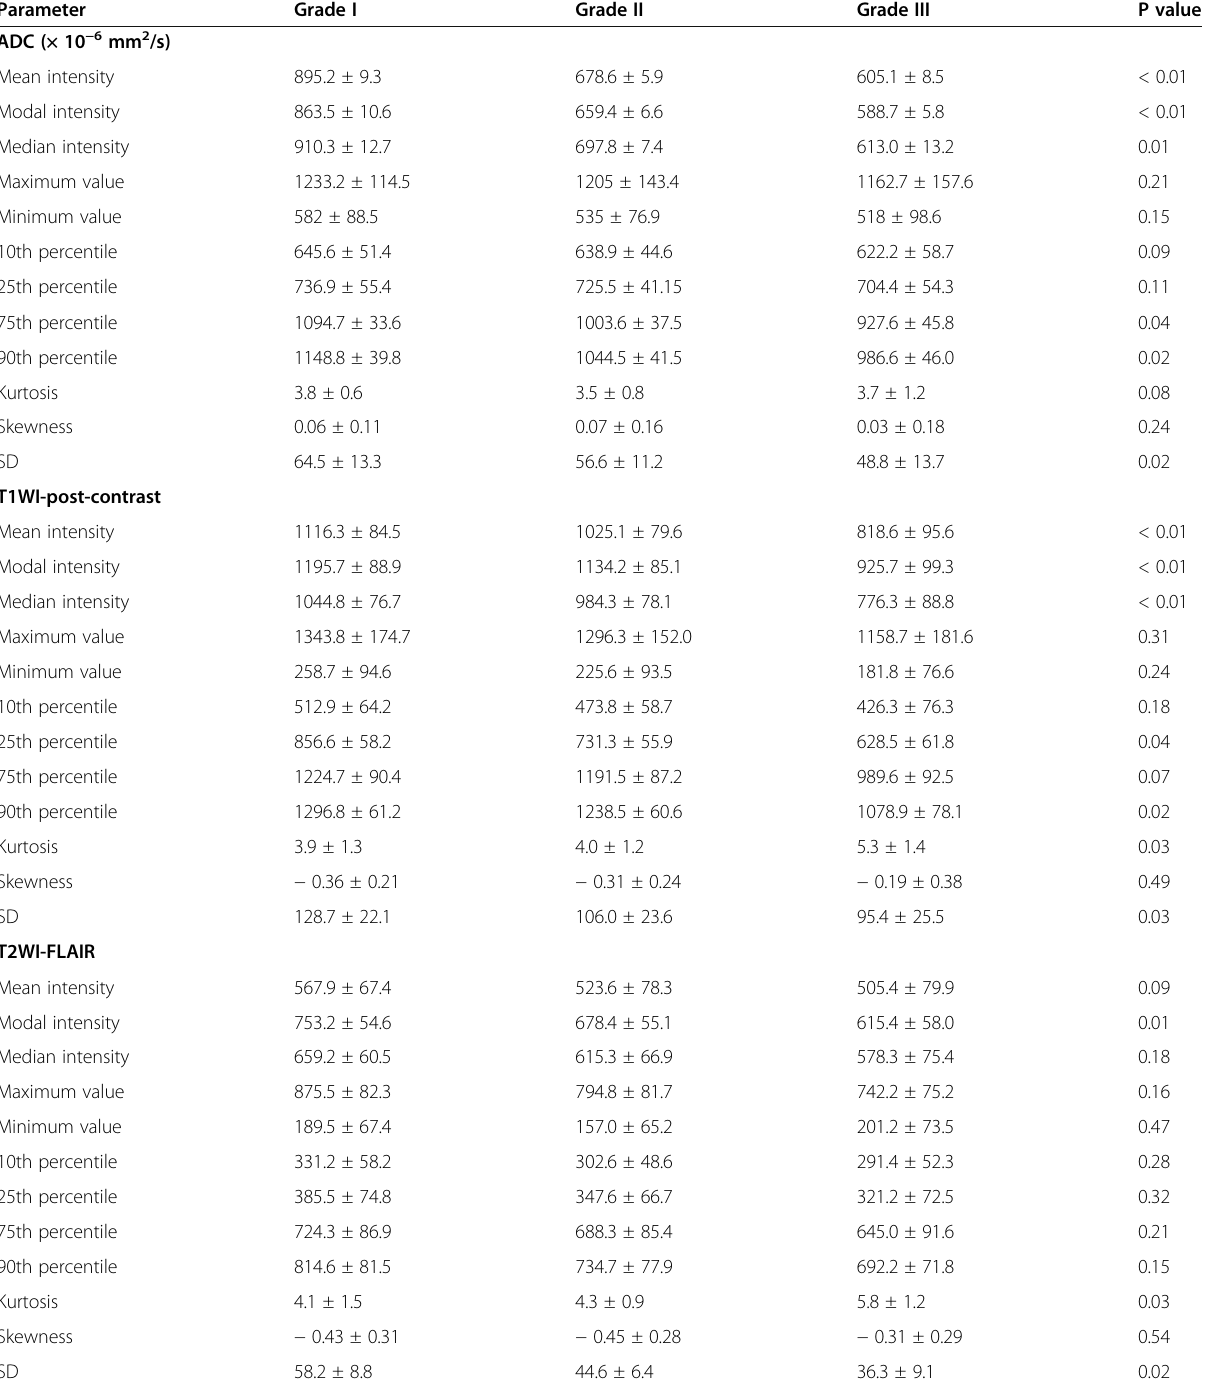
Table 1 Mean ± standard deviation of histogram parameters with resulted P values between different tumor grades obtained from ADC, post-contrast T1WI, and T2-FLAIR images Parameter Grade I Grade II Grade